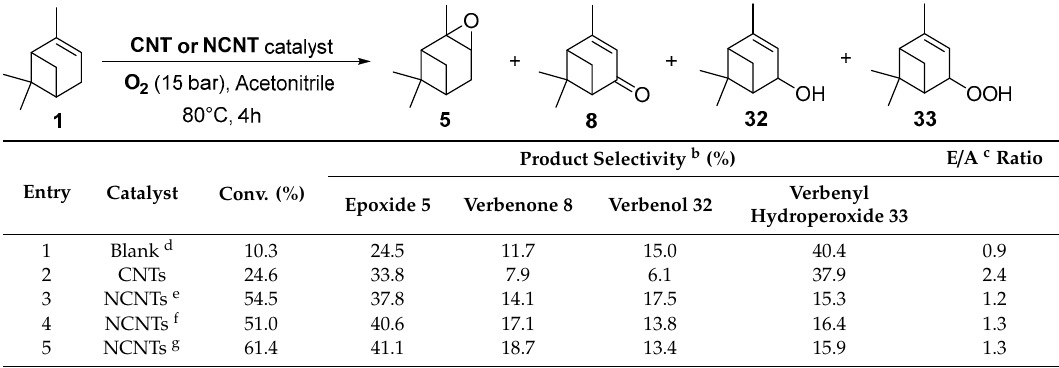
Table 3. Catalytic performances of carbon nanotubes in the oxidation of α -pinene 1 a (adapted from reference [29]).